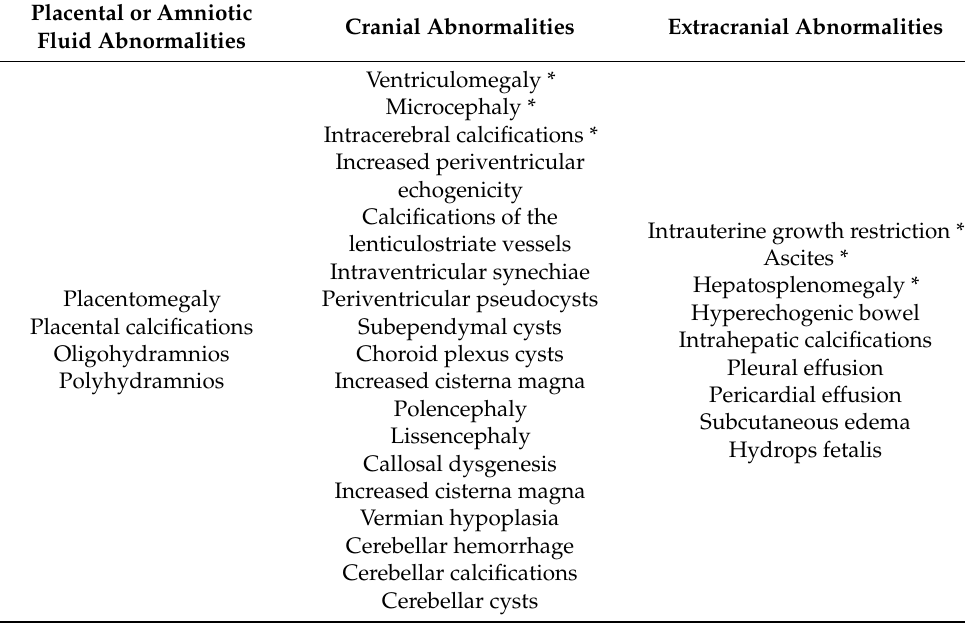
Table 1. Ultrasound fetal abnormalities suggestive of congenital cytomegalovirus